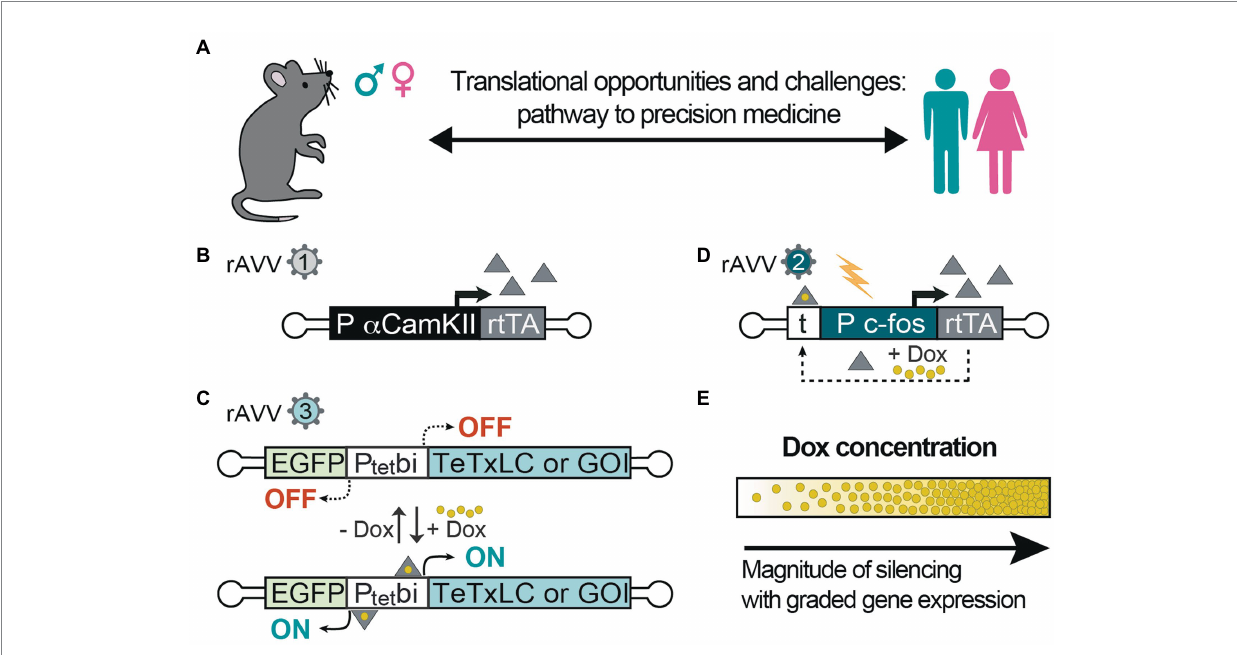
FIGURE 2 Inducible control of excitation-inhibition balance and gene activity. (A) Animal models are useful for testing specific hypotheses-driven experiments, also regarding gender differences in various pathologies and in response to therapy. Thus far, they represent a powerful approach to move preclinical studies into clinical trials; (B) Recombinant adeno-associated virus (rAAVs) can be equipped with α -calmodulin kinase-2 promoter ( α CaMK2) to express reverse tetracycline transactivator (rtTA; rAAV1), which upon (C) binding to the Ptetbi promoter (rAAV3) in the presence of doxycycline (Dox) activate the expression of tetanus toxin light chain (TeTxLC) to block evoked synaptic transmission in excitatory neurons. In the absence of Dox, the expression is switched-off and synaptic transmission can resume; (D) With another system based on c-fos promoter with upstream tetracycline operators (t), hyperactive cells are specifically targeted in the presence of Dox to express rtTA, which establishes an autoregulated loop for rtTA-dependent rtTA expression, thereby E/I can be controlled in the tagged cells using TeTxLC or any gene of interest (GOI) as in (C) . Indeed, these technologies